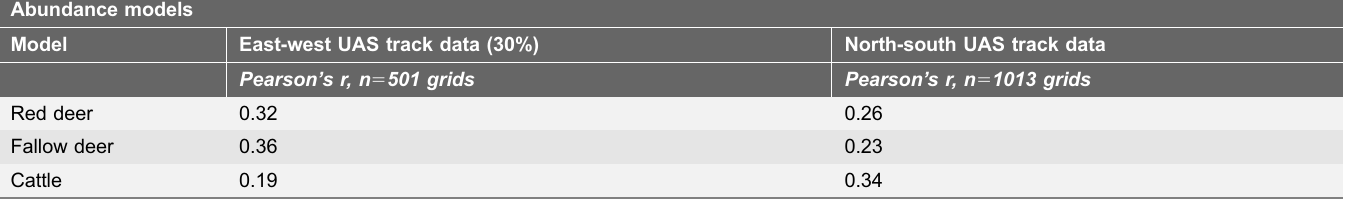
Table 3. Assessment of the predictive performance of the abundance models in independent datasets by using Pearson correlations ( p , 0.001 in all cases). Abundance